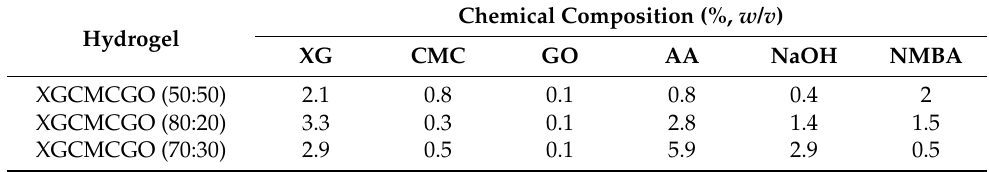
Table 5. Sample composition